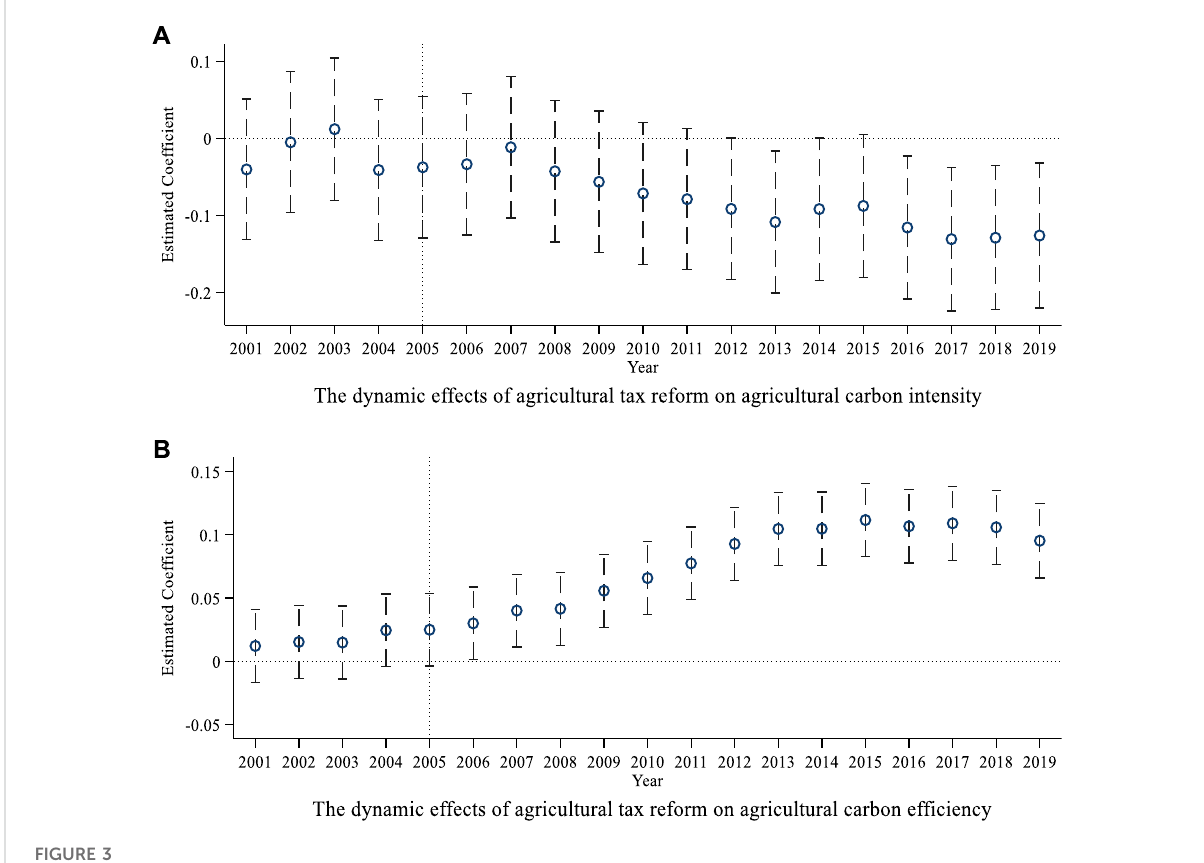
FIGURE 3 Dynamic effects analysis.